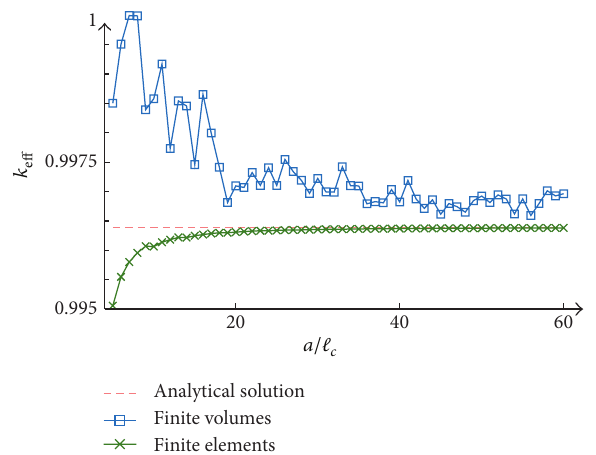
Figure 7: The effective multiplication factor of a two-group bare circularreactorofradius 𝑎 asafunctionofthequotient 𝑎/ℓ 𝑐 between the radius and the characteristic length of the cell/element.